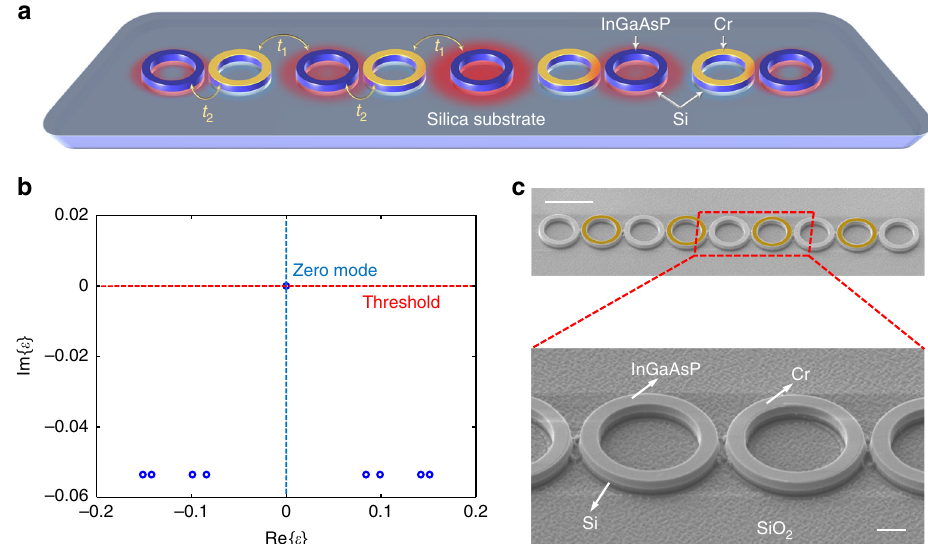
Fig. 1 Topological hybrid silicon microlaser. a Schematic of a topological laser array made of nine microring resonators with alternating weak ( t 1 ) and strong ( t 2 ) couplings, emulating an SSH model. A layer of 10-nm Cr (shown in yellow) is deposited on top of every second element to introduce distributed gain and loss. The red halos represent the intensity pro fi le of the oscillating zero mode that resides at the central site and decays exponentially away from the centre, with zero intensity in every second element. b Spectral features of the topological laser array, highlighting the lasing selectivity of the topological zero mode. Due to the charge-conjugation symmetry, the spectrum is symmetric around the imaginary axis. The blue circles represent the calculated eigenvalues of all the nine supermodes of the laser array. c SEM pictures of the fabricated structure consisting of nine rings on a hybrid III – V/silicon platform. Each ring has inner and outer radii of 3.5 and 4.5 µ m, respectively, and is made of 500 nm-thick InGaAsP quantum well layers on top of a 220 nm silicon layer grown on a silicon-on-insulator (SOI) substrate. The alternating 200 and 300 nm edge-to-edge separations between adjacent rings realise the weak coupling t 1 = 78 GHz and the strong coupling t 2 = 134 GHz, compositing an estimated Hermitian topological band gap of 112 GHz in the absence of loss. In the top panel of c , we highlighted the Cr layer with arti fi cial yellow rings for better visualisation of the arrayed structure, since the Cr layer is only ~10 nm thick and dif fi cult to be clearly seen, especially in pictures of low magni fi cation. Scale bars in c : low magni fi cation: 10 µ m; high magni fi cation: 2 µ